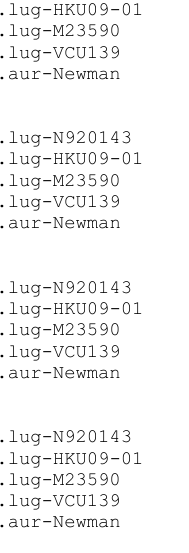
Figure 1. Multiple sequence alignments of SrtA sequences of four strains of S. lugdunensis (N920143, HKU09-01, M23590, and VCU139) and S. aureus Newman using CLUSTAL 2.1. The highly conserved amino acids glutamate (E) and aspartate (D) involved in binding of calcium ions are highlighted in yellow. Stars denote highly conserved amino acids.